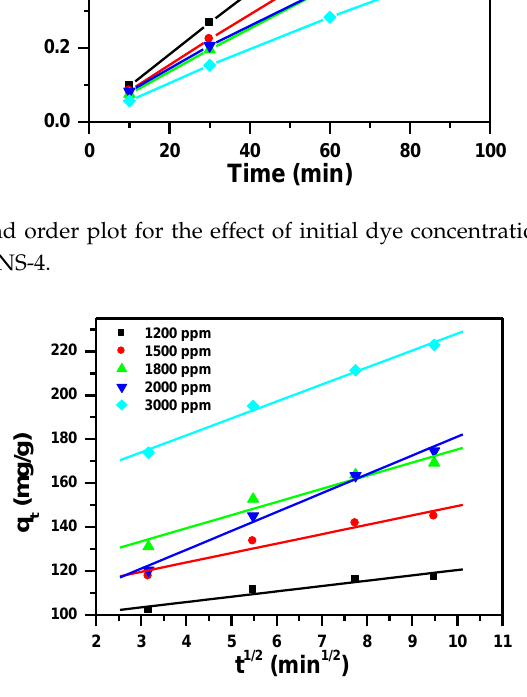
Figure 10. Intra-particle diffusion plot for the effect of initial dye concentration and contact time on removal of MB using MNS-4.